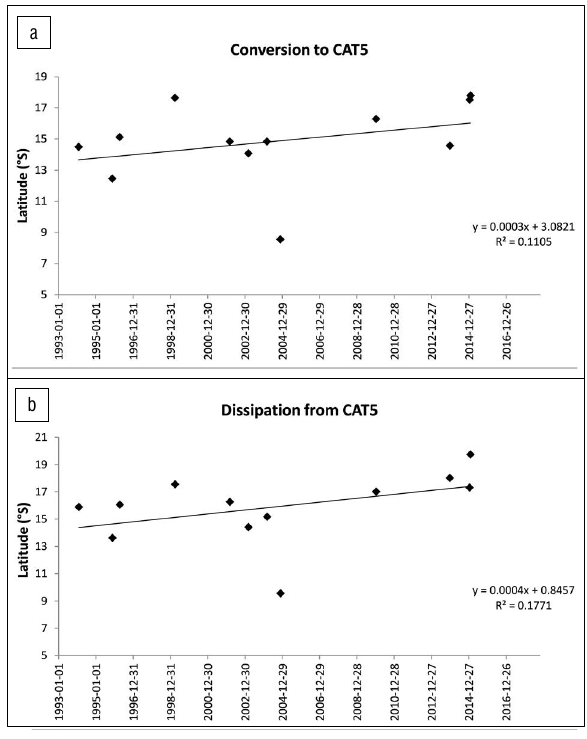
figure 1: Latitudinal position of each CAT5 tropical cyclone storm track at the point of (a) intensification to and (b) dissipation from category 5